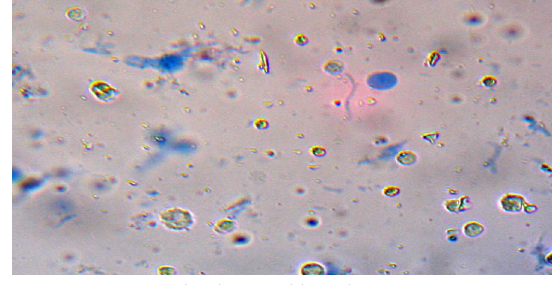
Fig. 5 HDPSCs stained with trypan blue solution